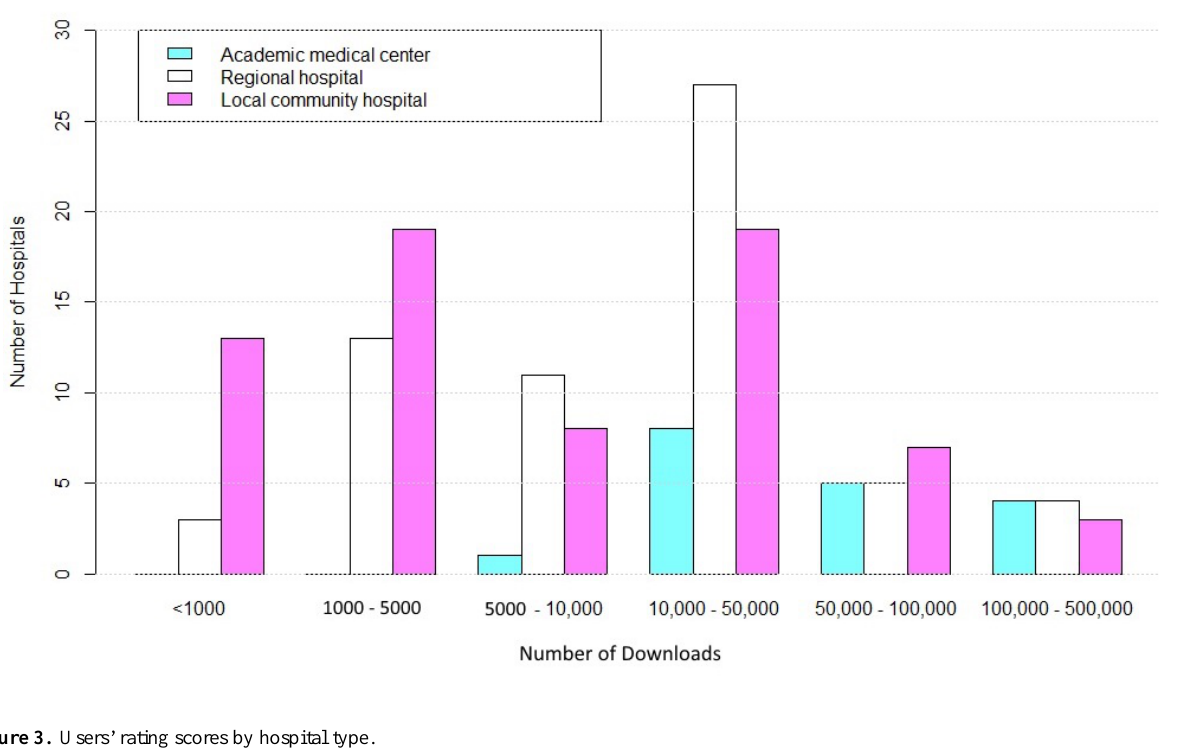
Figure 2. Download distribution of hospital-owned apps (N=150).